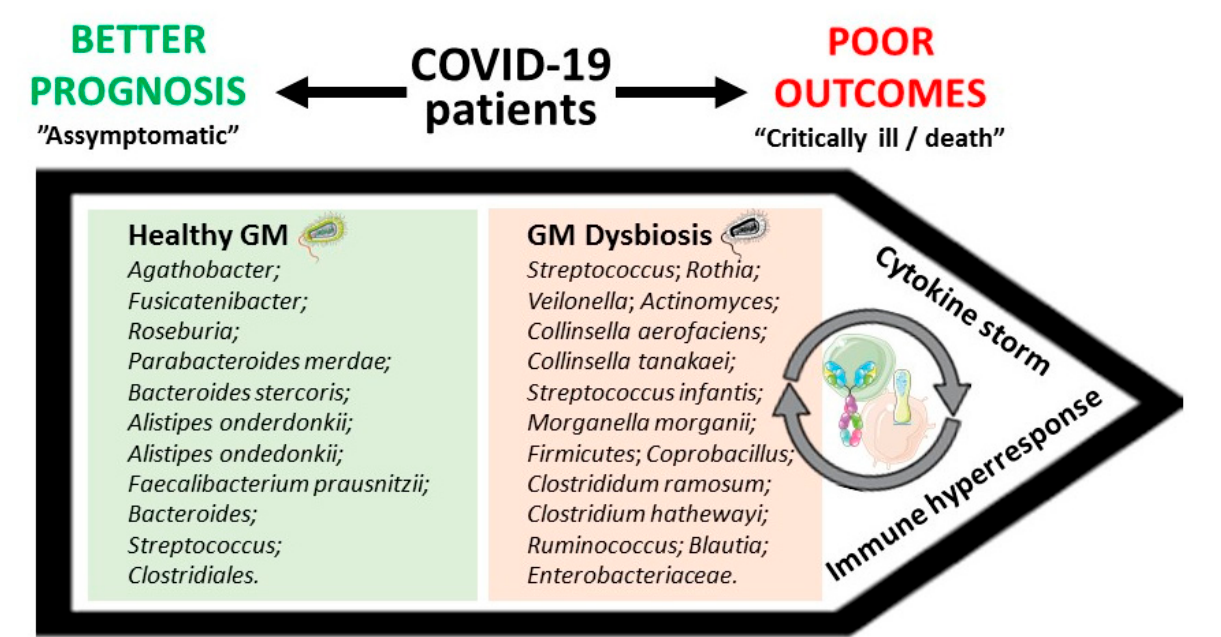
Figure 1. Putative correlation between Coronavirus Disease 2019 (COVID-19) clinical outcomes and gut microbiota (GM) composition. Green and red squares display some examples of bacteria encompassing better or poor COVID-19 outcomes, respectively.